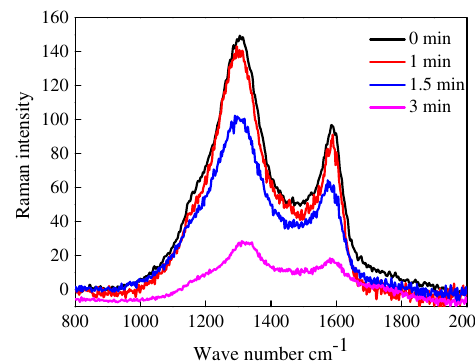
Fig. 7 Original Raman spectrogram of YCW semi-chars with 5 wt% IWC loaded at 1000